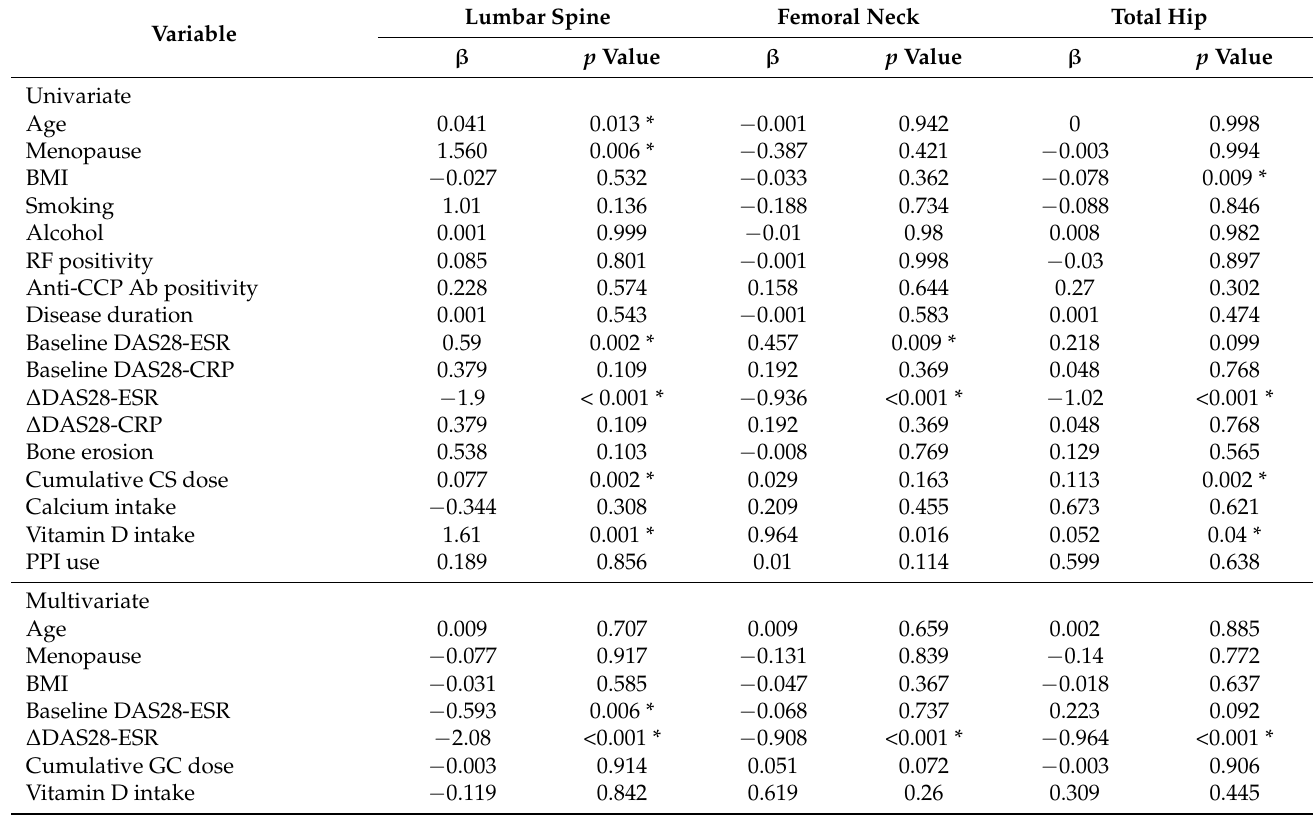
Table 4. Multiple linear regression analysis of risk factors associated with annualized BMD